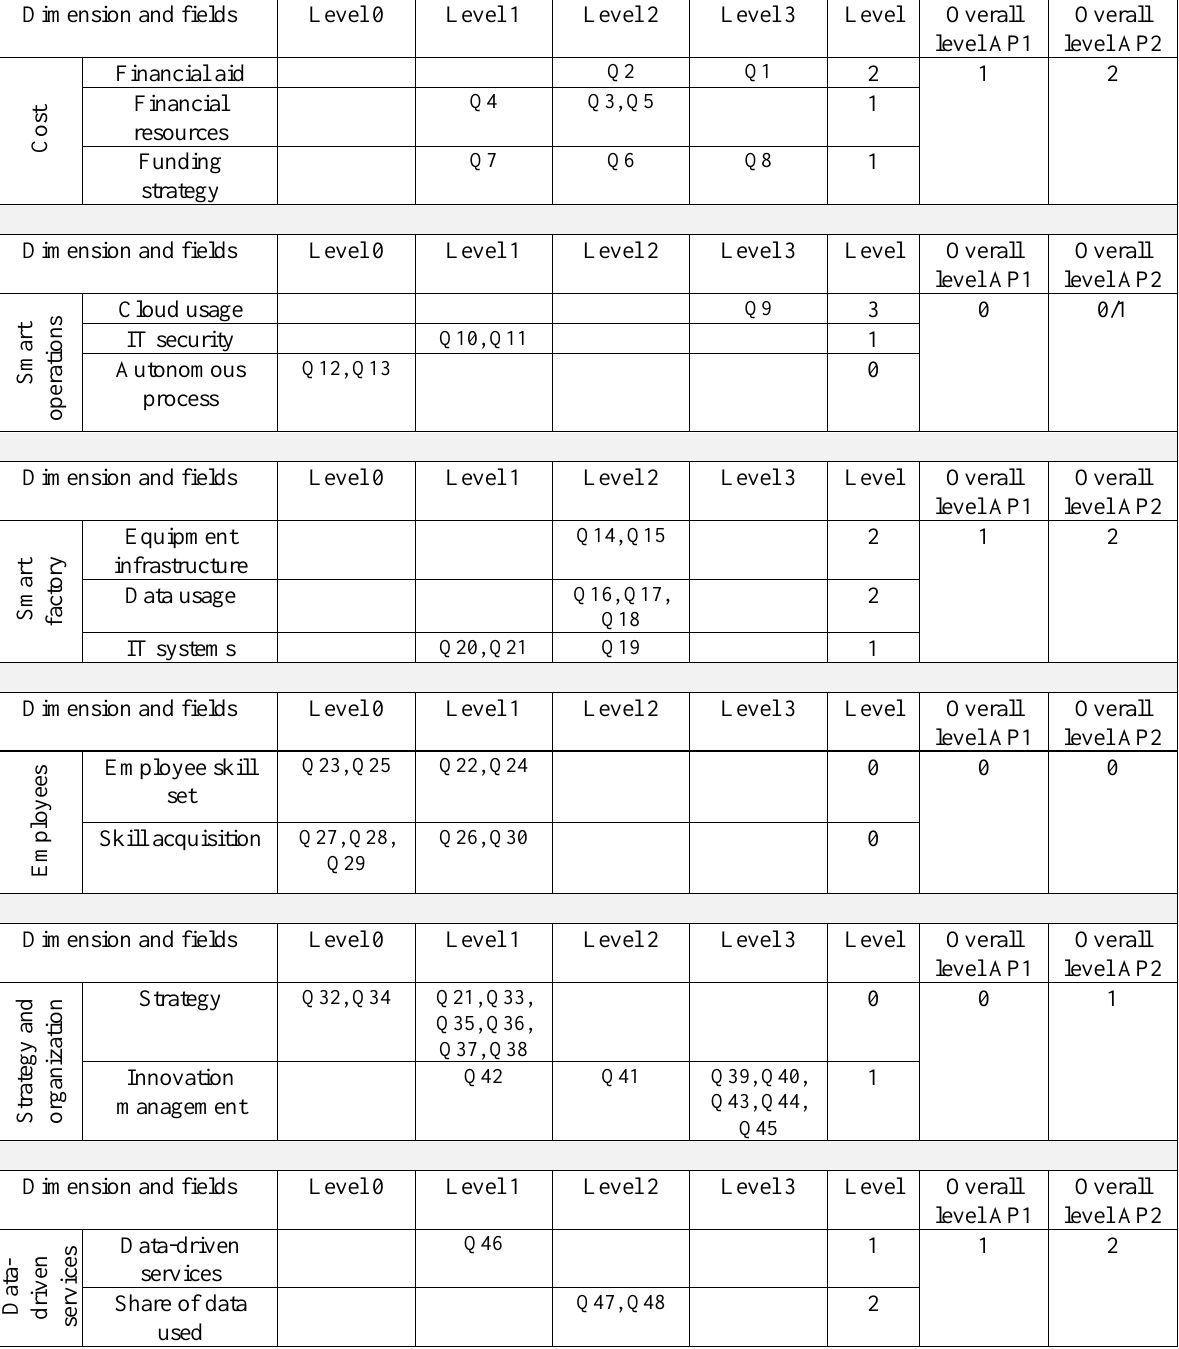
Table 4 . Readiness assessment